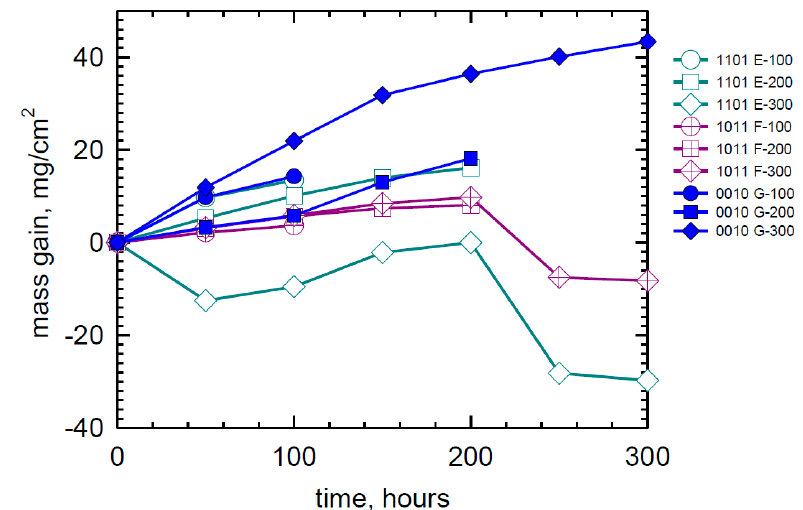
Figure 4. Weight change behavior of duplicate high-Mo LDS SXSA samples in LTHC re-coat furnace tests at 700 °C showing large gains or large losses for specific alloys. See Table 1 for alloy coding. (80Na-20K) 2 SO 4 sulfate salt spray, 0.5 mg/cm 2 every 50 h, 25 h cycles. pSO 2 = 300 ppm in air.